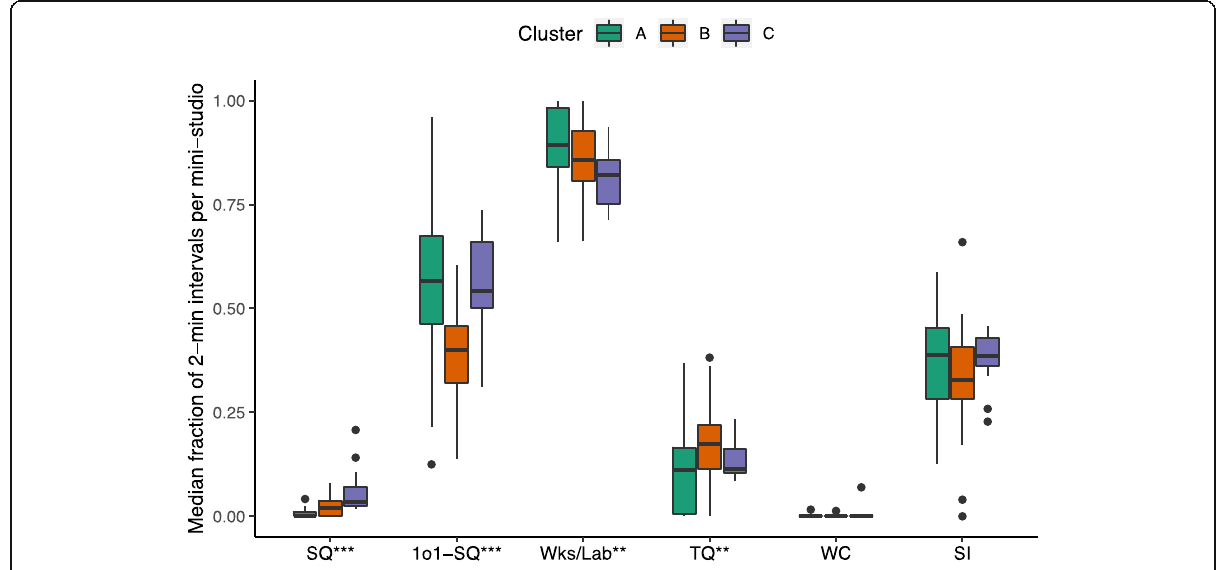
Fig. 7 Median fraction of student code in each cluster in physics mini-studios (combined tutorial and laboratory). Four codes are statistically significantly among different clusters, two of which (SQ, 1o1-SQ) have large effect sizes and two of which (Wks/Lab, TQ) have medium effect sizes. ***Large effect sizes. **Medium effect